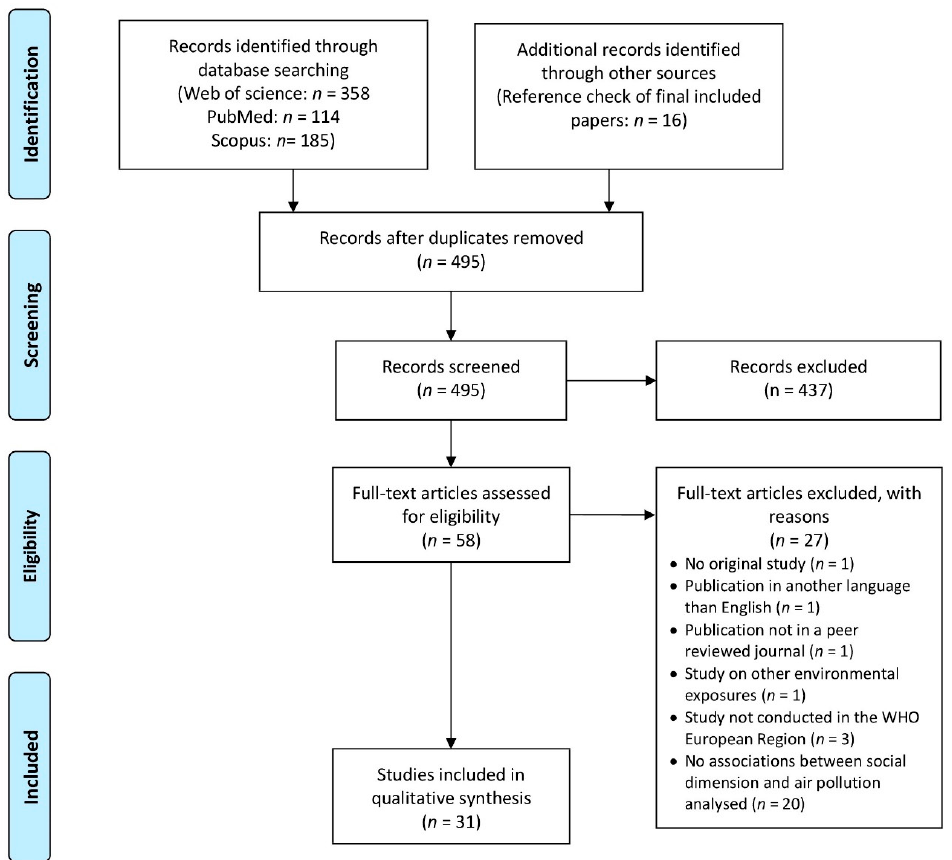
Figure 1. Flow diagram of study selection adapted from the preferred reporting items for systematic reviews and meta-analyses (PRISMA) statement [18].